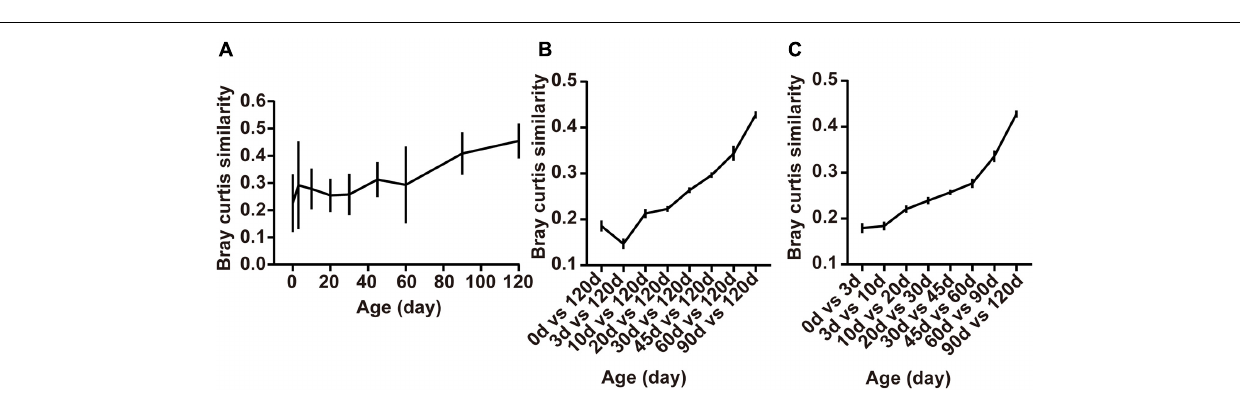
FIGURE 4 | Changes in rumen bacterial diversity as the lambs age. (A) The Bray-Curtis similarity within groups, (B) between samples collected from birth to 90 days of age and those collected at 120 days of age, and (C) the similarity between adjacent time points. Data are expressed as mean ±